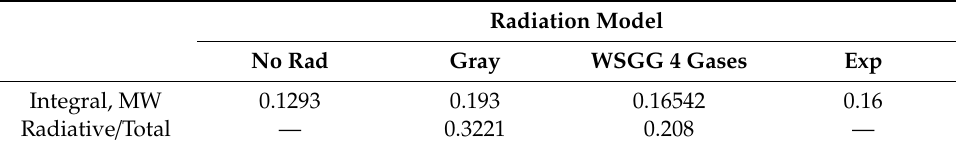
Figure 10. Segment average heat flux distribution. Table 2. Influence of the radiative heat transfer spectral